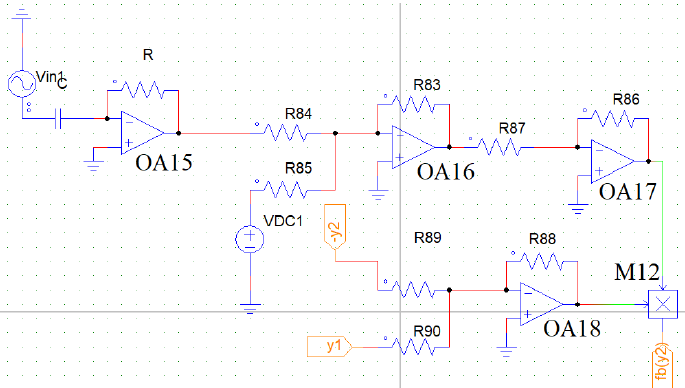
Figure 16. The equivalent circuit diagram of the non-dimensional spring force term β 2 ( τ ) . The resistance values are: R = R 84 = R 85 = R 83 = R 86 = R 87 = R 88 = R 89 = R 90 = 100 k Ω . The capacitor C = 1 nF. OA15, OA16, OA17, and OA18 are the four Op-Amps, M 12 is the multiplier. V in1 is the sine wave. V DC1 is a dc voltage source of value 7.2284 V. (Color